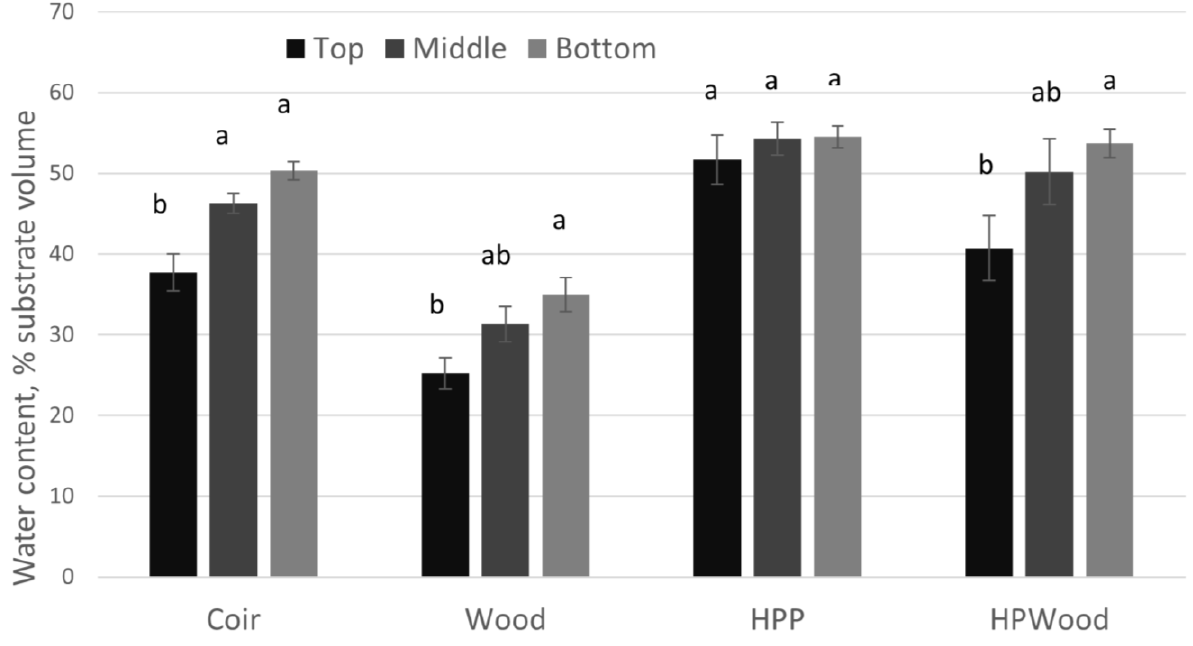
Figure 4. Water content in different substrates and on different levels in arctic bramble plant towers on 14 April (13 weeks from planting), as a percentage of total substrate volume. Vertical bars represent ± SE (n = 6). Different lowercase letters indicate statistically significant differences between the levels within each substrate (P < 0.05) by Tukey’s